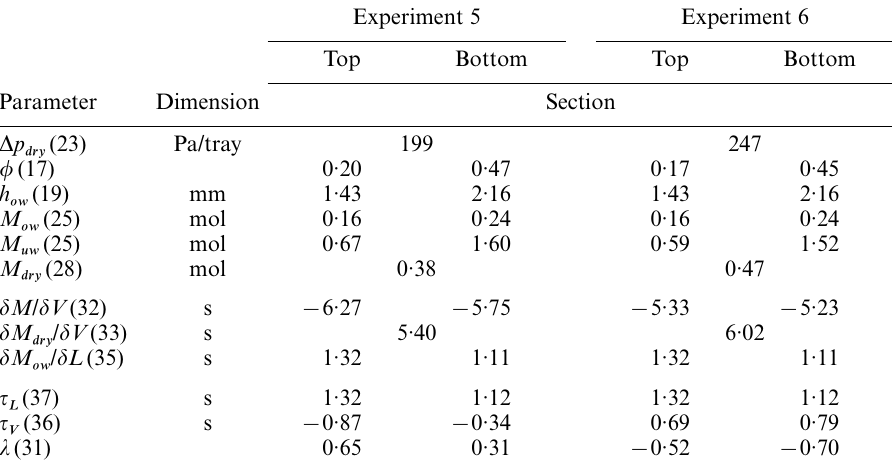
Table 1. Numerical example, estimated data for experiments 5 and 6 Experiment 5 Experiment 6 Top Bottom Top Bottom Parameter Dimension